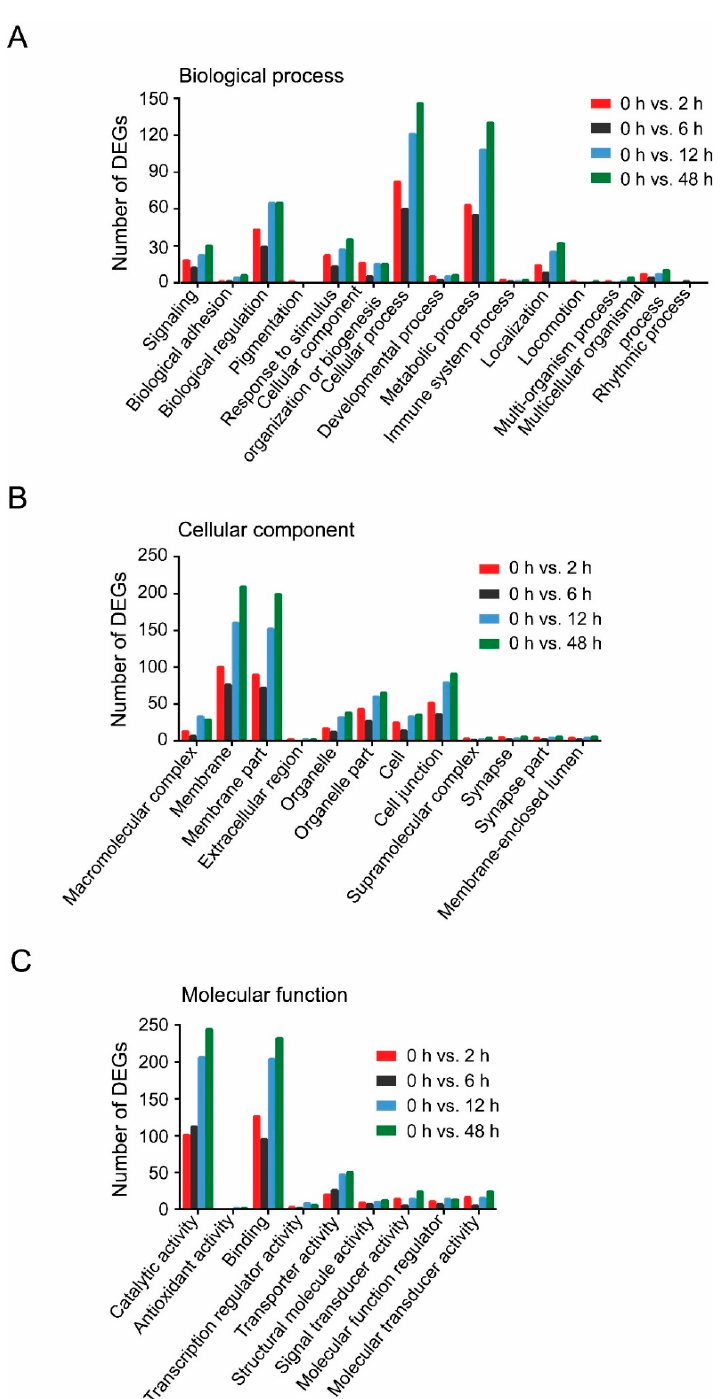
Figure 3. GO categories of DEGs. ( A ) Biological process; ( B ) Cellular component; ( C ) Molecular function. Different colors represent different comparisons.